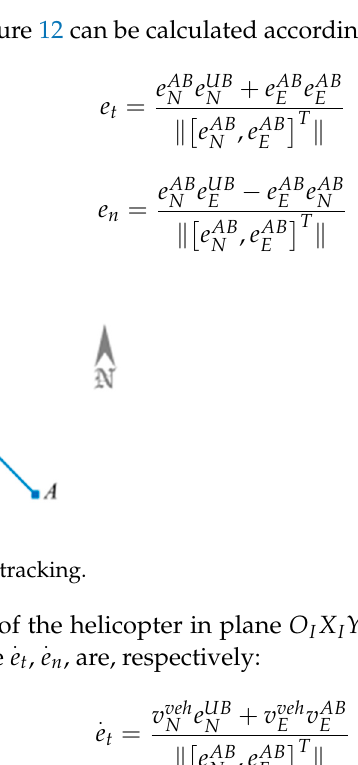
Figure 11. Diagram of point-to-point tracking.